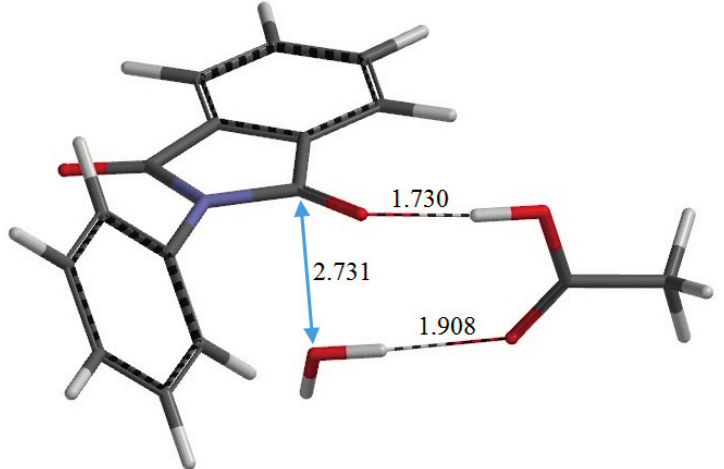
Figure 7. The geometry of the second-step transition state TS2. The distances of forming and breaking bonds are shown in Å.